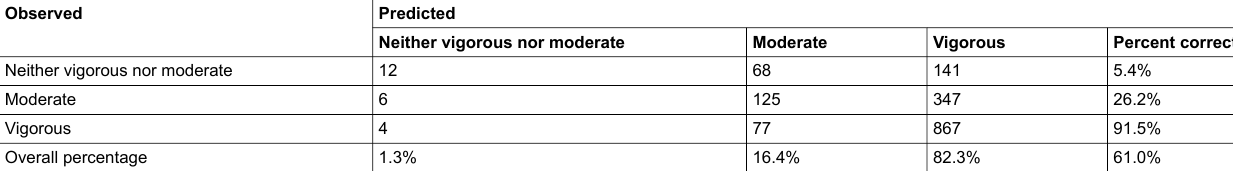
Table 4: Classification table of the observed and predicted cases by multinomial logistic